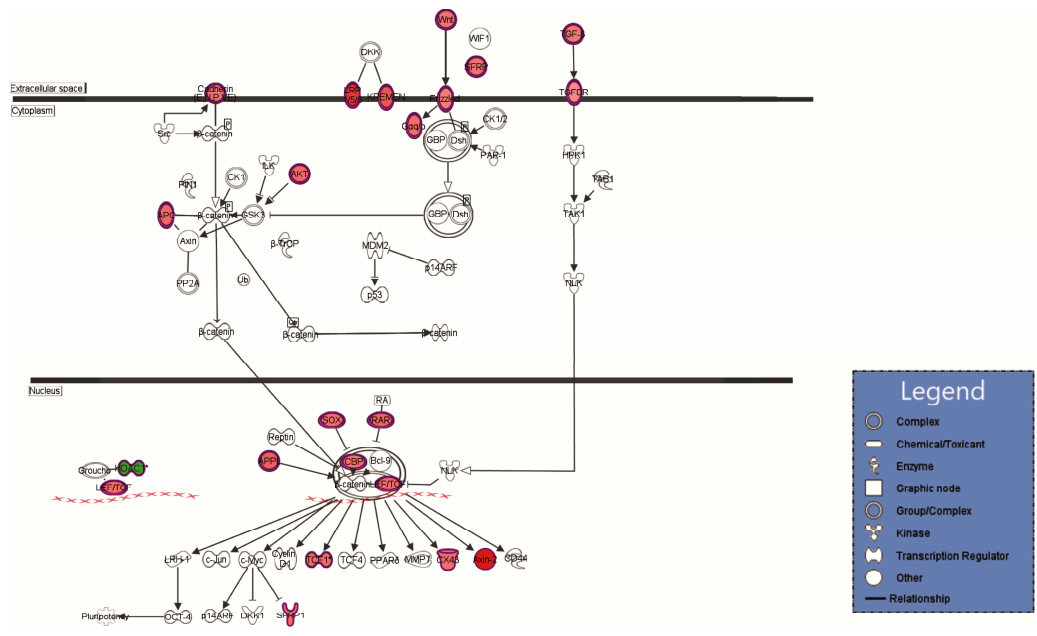
Figure 2. The predicted molecular connections between the differentially regulated genes in the extracellular space, cytoplasm, and nucleus of IPEC-1 cells. Information about the regulation of genes is included in the figure: the red color gradient from dark to light shows the degree of genes up-regulated in lactobacilli treated IPEC cells versus control cells; the green color shows the down-regulated in lactobacilli treated IPEC cells versus control cells; arrow ( ) = direct relationship; ( ) = inhibition.